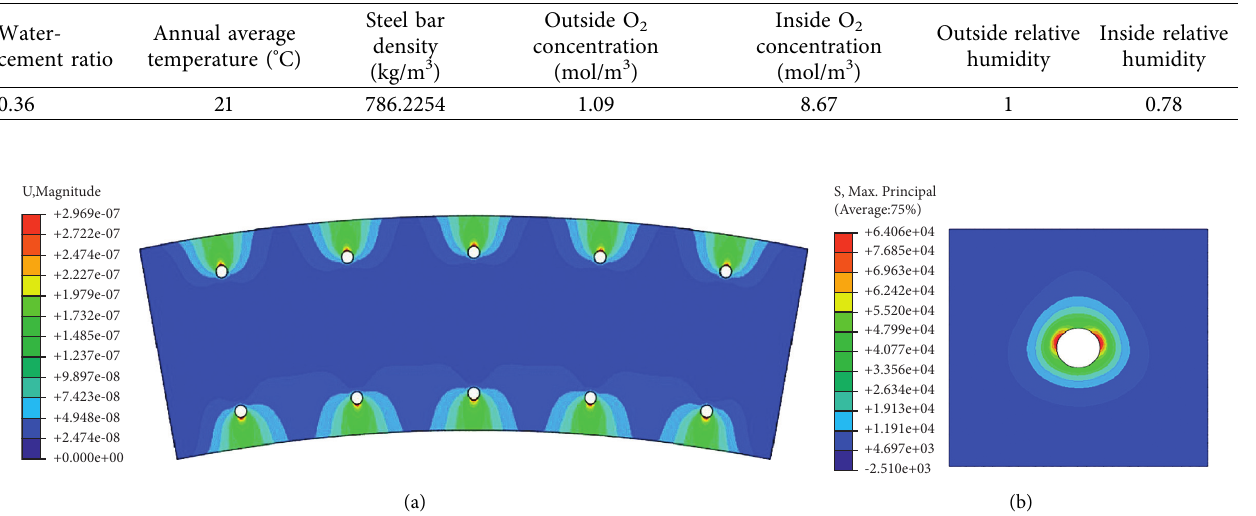
Table 5: Relevant parameter values for computing steel bar corrosion-induced displacement.